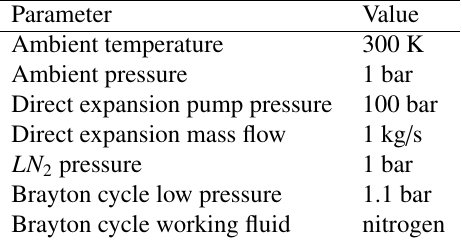
Table 2. Combined cycle